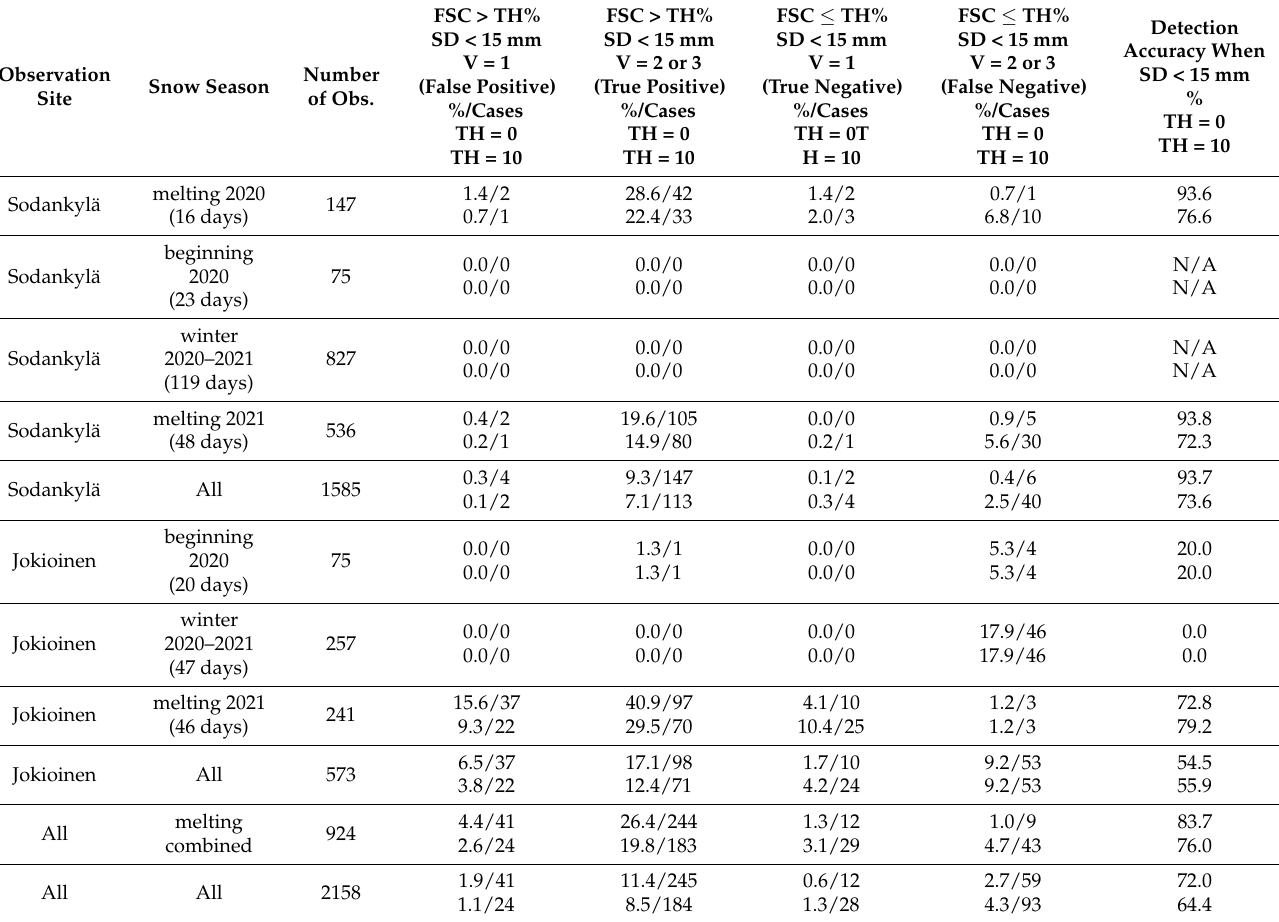
Table 5. Analysis results of the comparison between FSC data, SD data and visual inspection in Sodankylä and Jokioinen. TH% is the threshold of the FSC data to be taken into the analysis. V is the snow presence category from the visual inspection, values 1, 2 and 3 considered in the